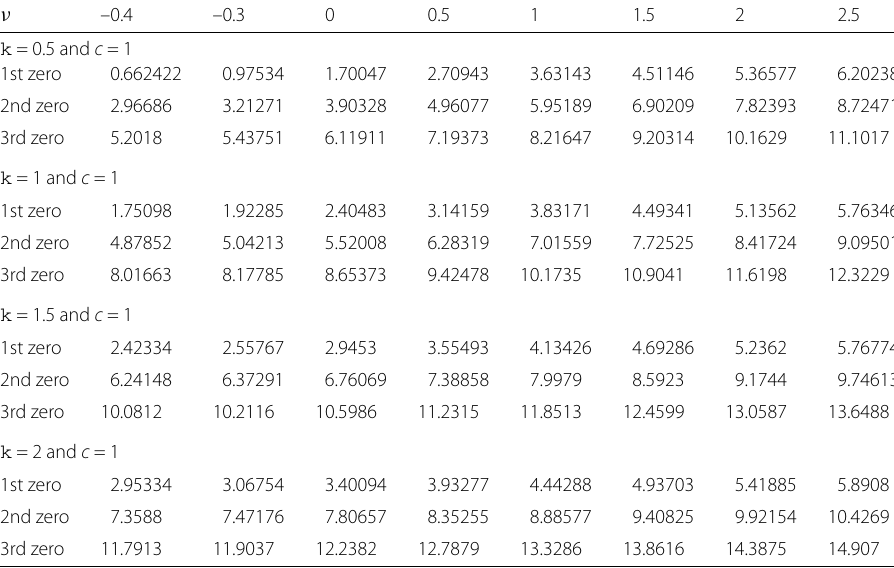
Table 2 Positive zeroes of W k ν